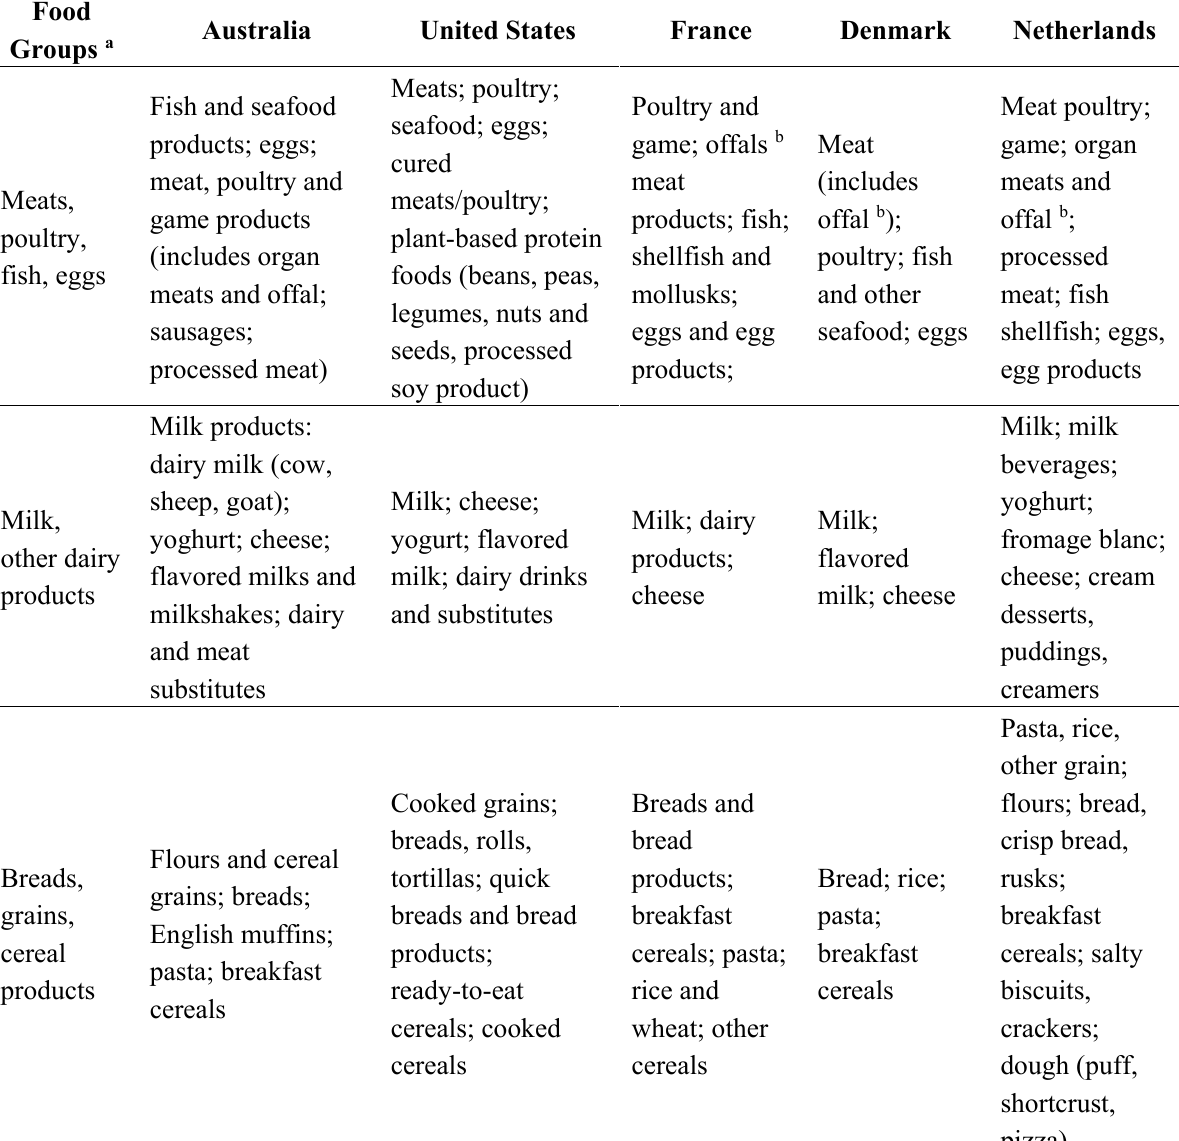
Table 2. Classification of foods into food groups based on national food consumption survey